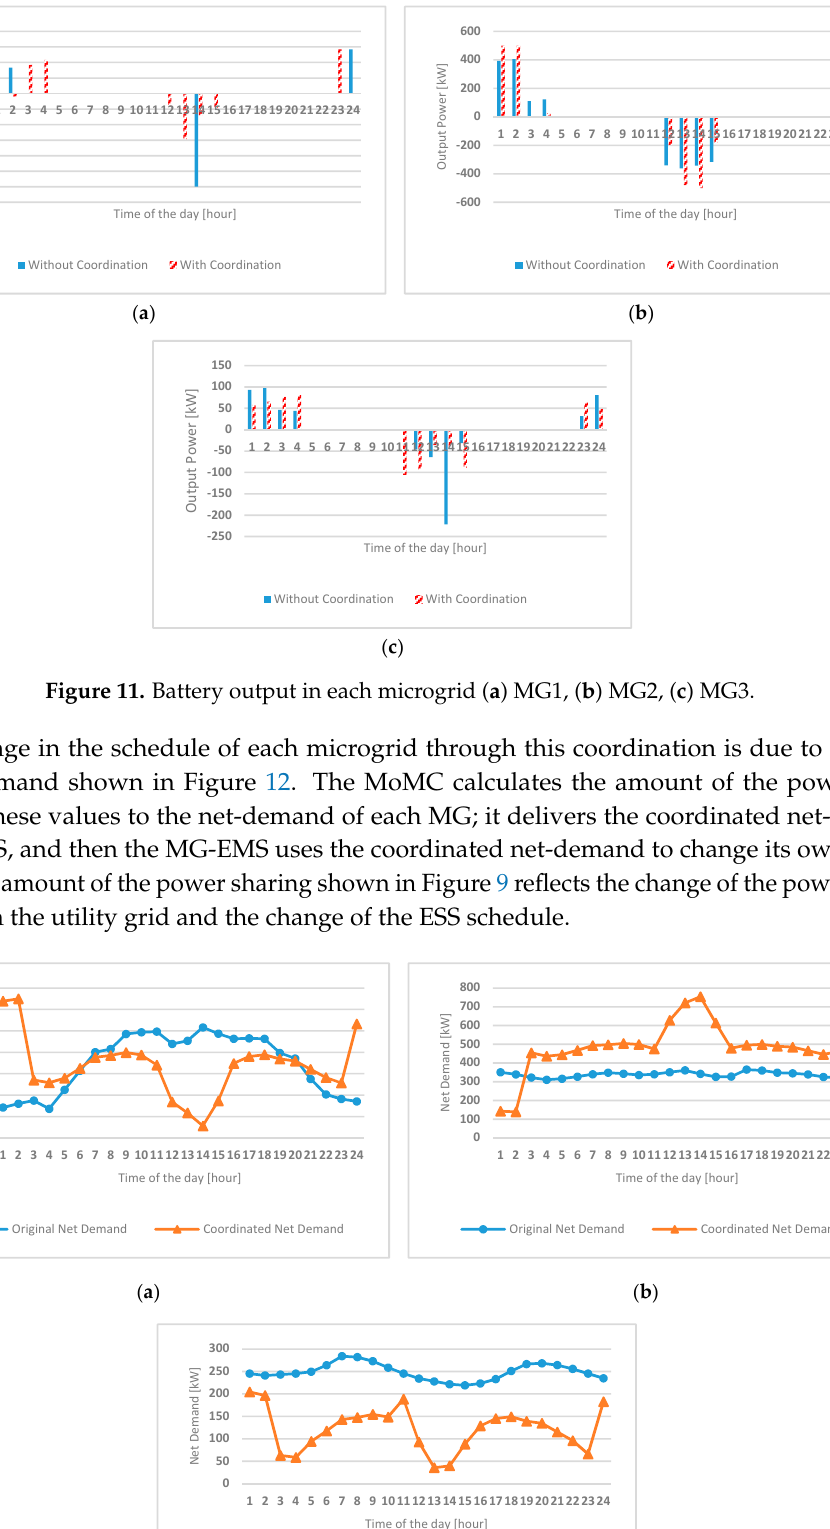
Figure 10. Battery SOC in each microgrid ( a ) MG1, ( b ) MG2, ( c ) MG3.